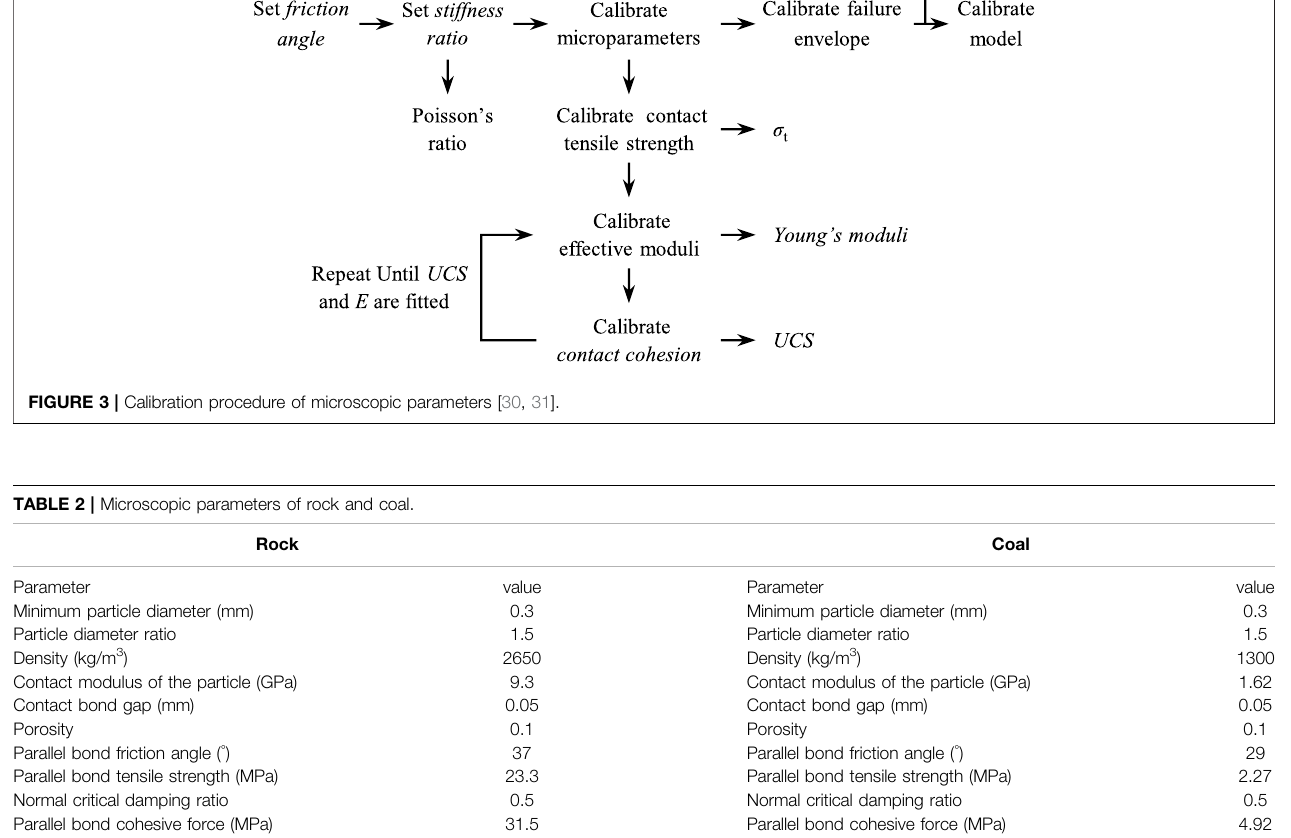
peak strength obtained by numerical simulation are consistent with the results of the laboratory uniaxial compression test. In terms of peak strain, the experimental and numerical simulation